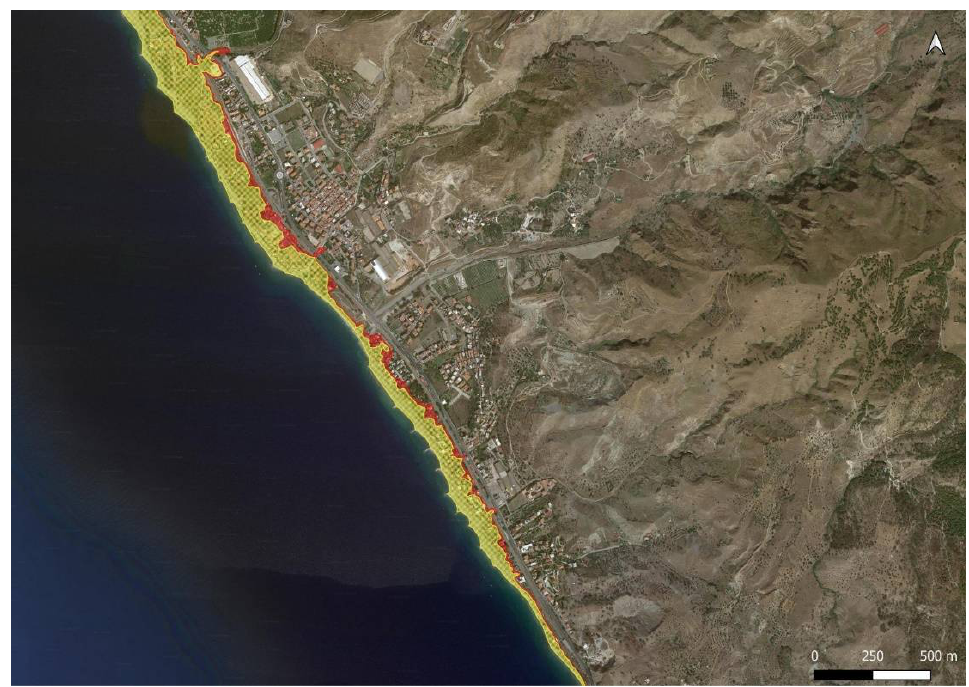
Figure 3. Rossano. Legend: Yellow ,the floodable area in the current scenario; red, the floodable area in the future scenario.